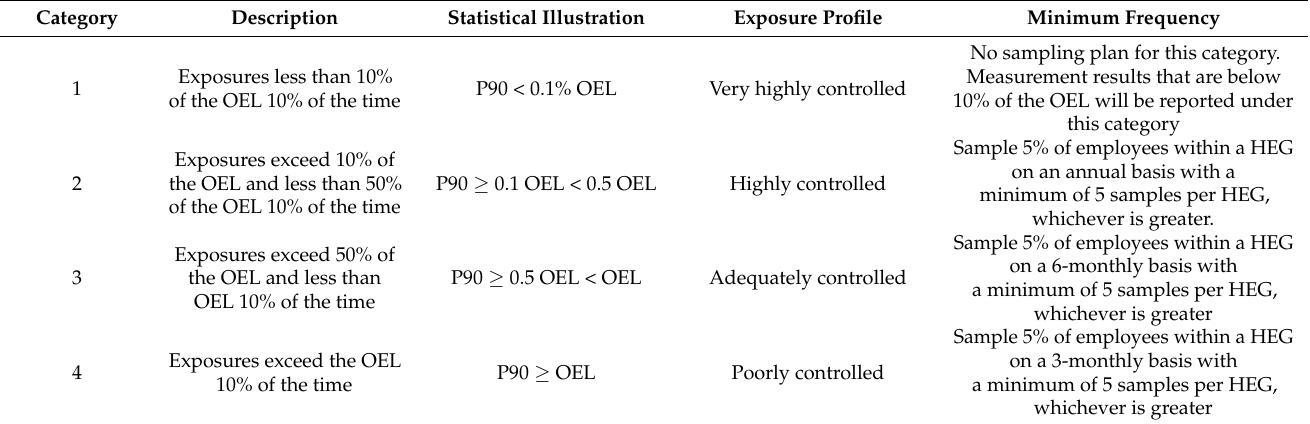
Table 1. The exposure classification categories for classifying the P90 of exposure relative to the OEL and sampling strategy of HEGs in the SAMI